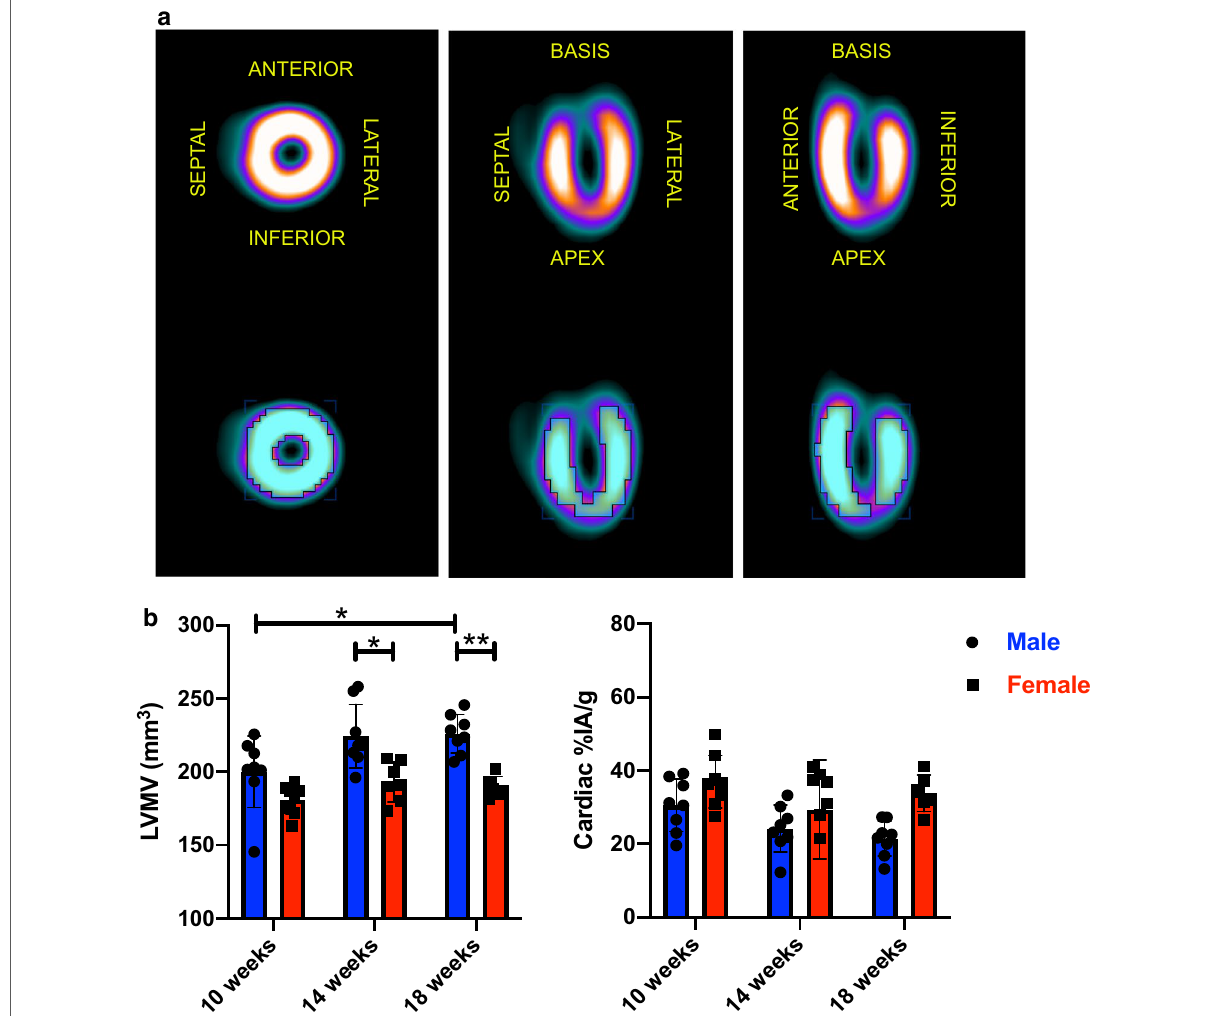
Fig. 1 Changes in LVMV and cardiac %IA/g in ageing mice. a Representative cardiac PET scan images for LVMV and %IA/g are illustrated. The upper panel shows the accumulation of 18F-FDG in the left ventricle in the coronal, the horizontal long axis and the vertical long axis. The lower panel of the left ventricle shows the VOI where the 30% least hottest voxels were excluded. b Shows the LVMV and cardiac %IA/g for male (in blue) and female mice (in red) at 10, 14 and 18 weeks of age. All groups n